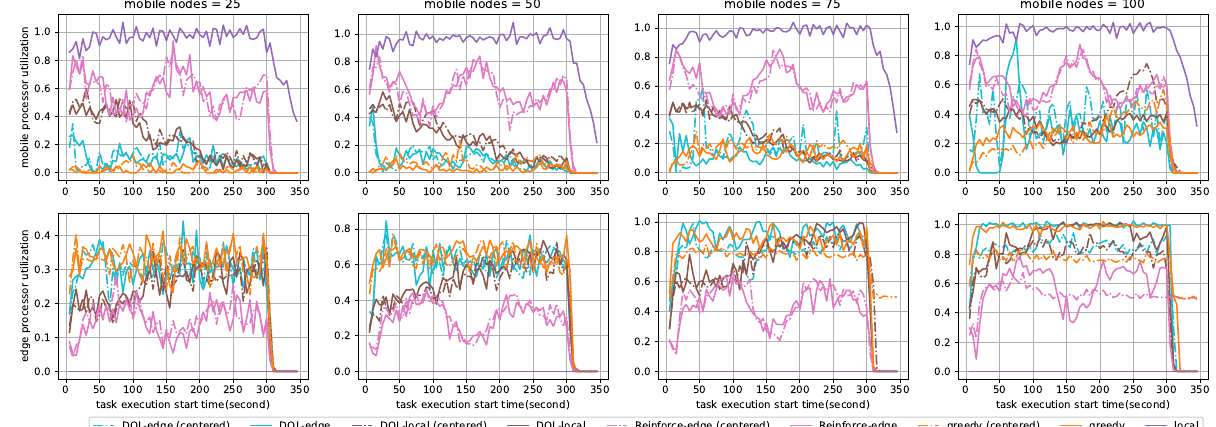
Figure 4. Comparing the mobile and edge processor utilization of the DQL-edge, DQL-local, reinforce- edge, greedy, and local task offloading models for the duration of the simulation with an extra 50 s after the task arrival process is stopped. The simulation was run for both centered and uniform positioning of mobile devices and when the number of mobile devices was 25, 50, 75, and